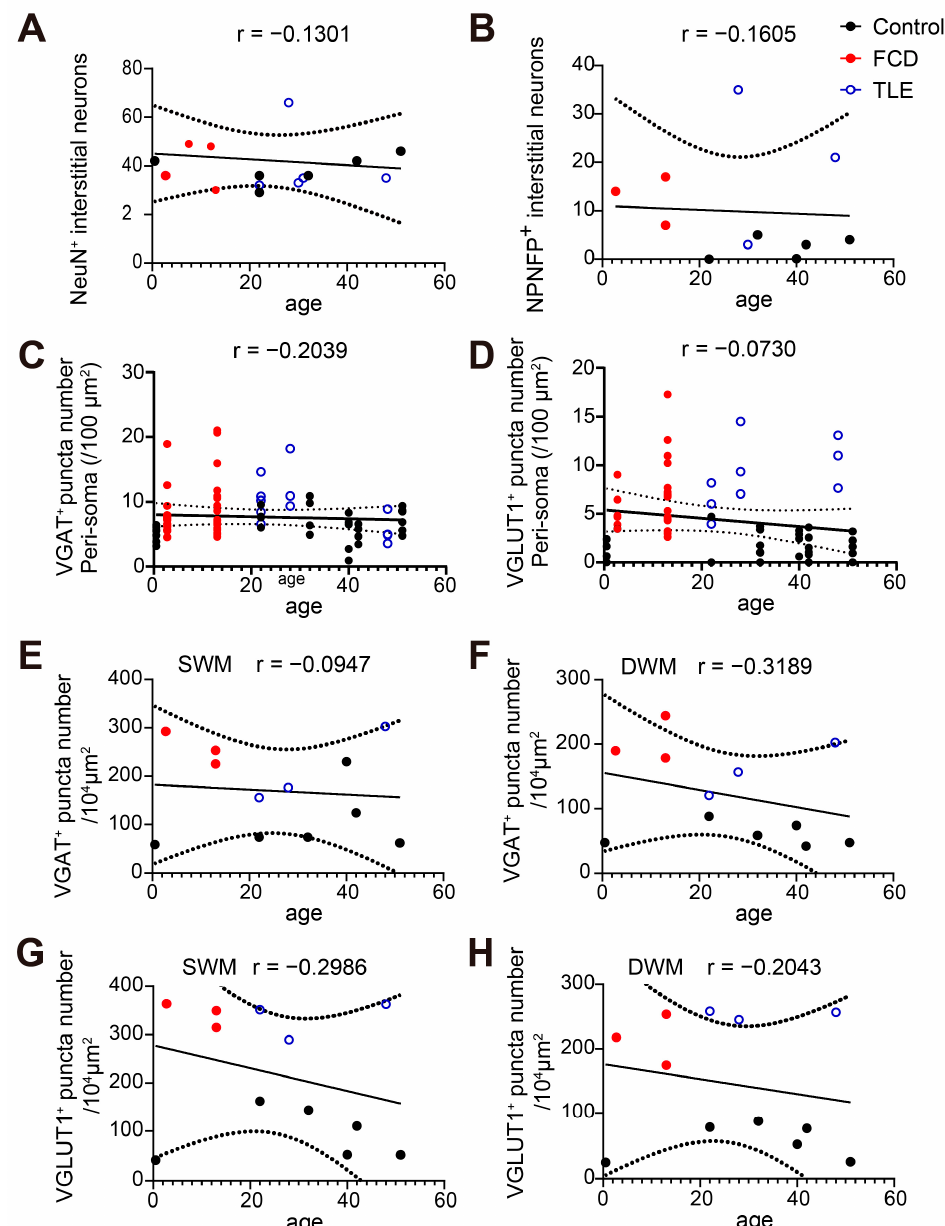
Figure 5. Linear regression and correlation analysis showed no correlation between the measured parameters and the age of brain samples. ( A – F ) Linear regression and correlation analysis showed no correlation between the number of NeuN- ( A ) or NPNFP-positive ( B ) interstitial neurons or the number of VGAT- ( C , E , F ) or VGLUT1-positive ( D , G , H ) puncta and the age of brain samples. SWM: superficial white matter; DWM: deep white matter. r: Pearson correlation coe ffi cient.